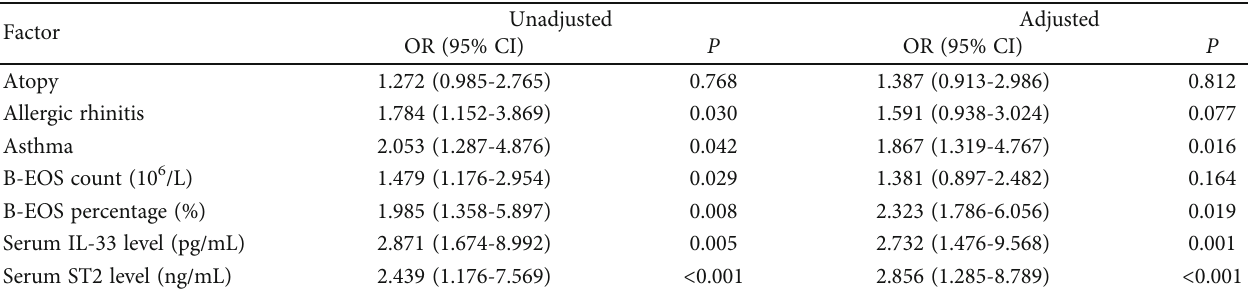
Table 4: Unadjusted and adjusted multivariate logistic regression analysis of factor associated with eCRSwNP. Resutls were adjusted for age, gender, smoking, BMI, atopy, allergic rhinitis, asthma and Lund-Mackay score, Lund-Kennedy score, and VAS score. Unadjusted Factor